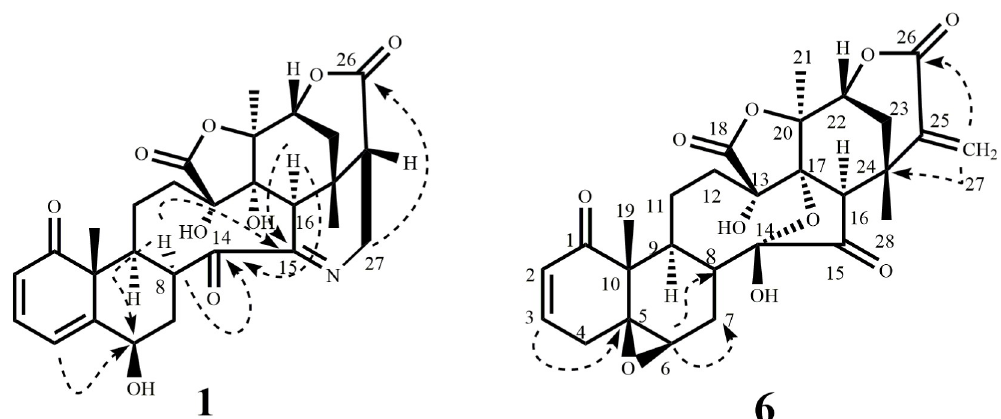
Fig 2. Key COSY (————) and HMBC (----- >> ) correlations in compounds 1 and 6.